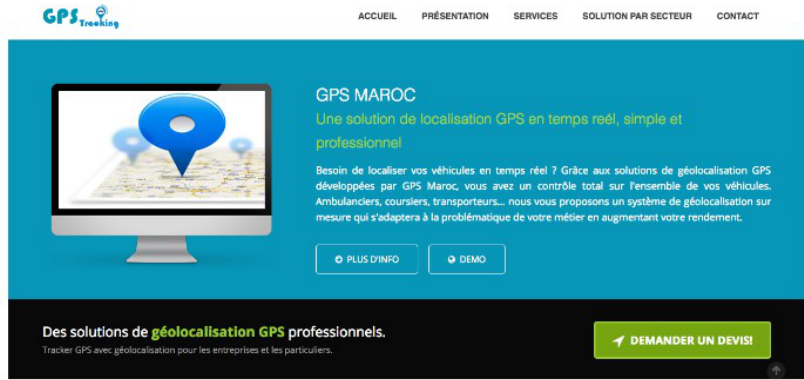
Figure 20. Morocco geo-localization